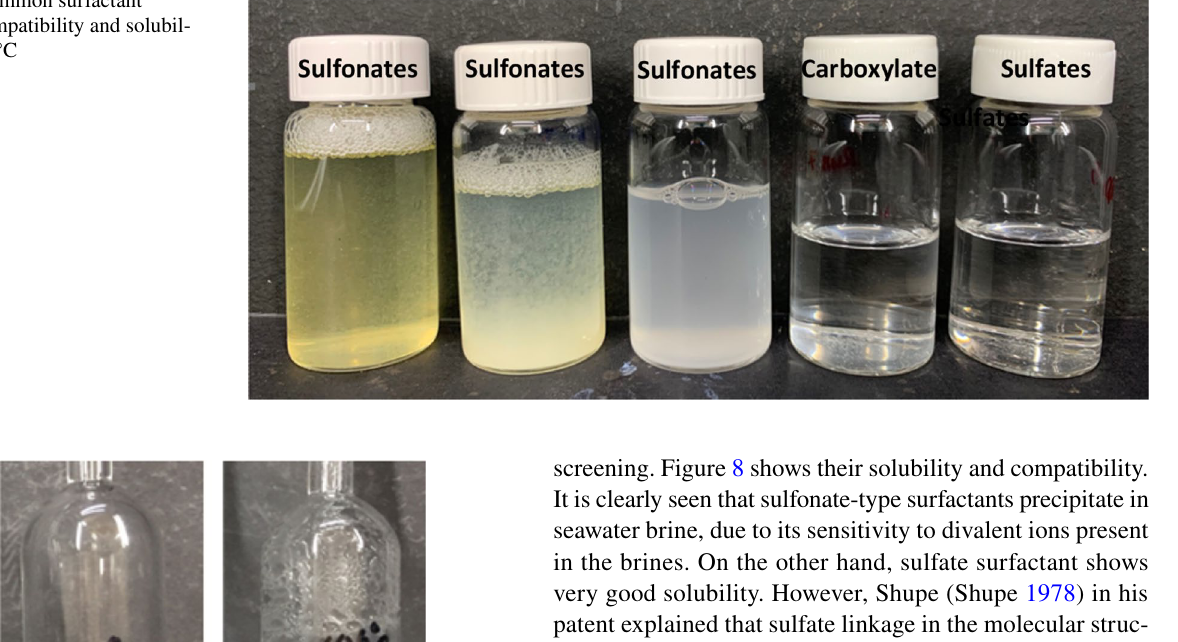
Fig. 8 Common surfactant type’s compatibility and solubil- ity, at 25 °C